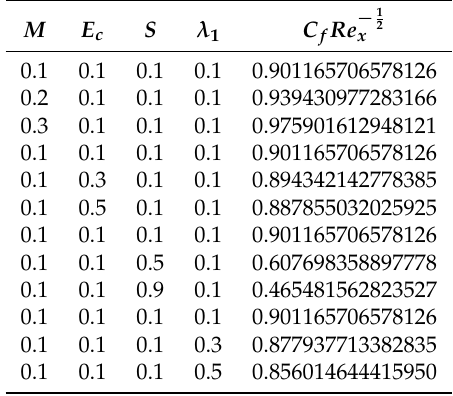
Table 1. Effects of selected parameters on the skin friction when n = 1.0, We = 3.0, Pr = 1.1, N b =